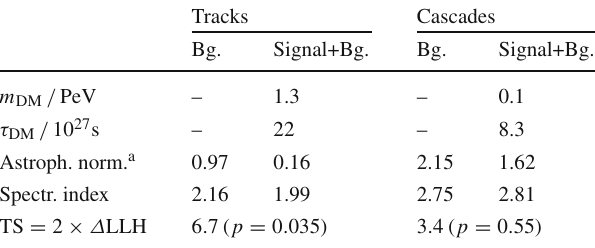
Table 2 Best-fit results assuming the decay channels DM → H + ν (cascades) and DM → Z + ν (tracks). Background p-values are stated in